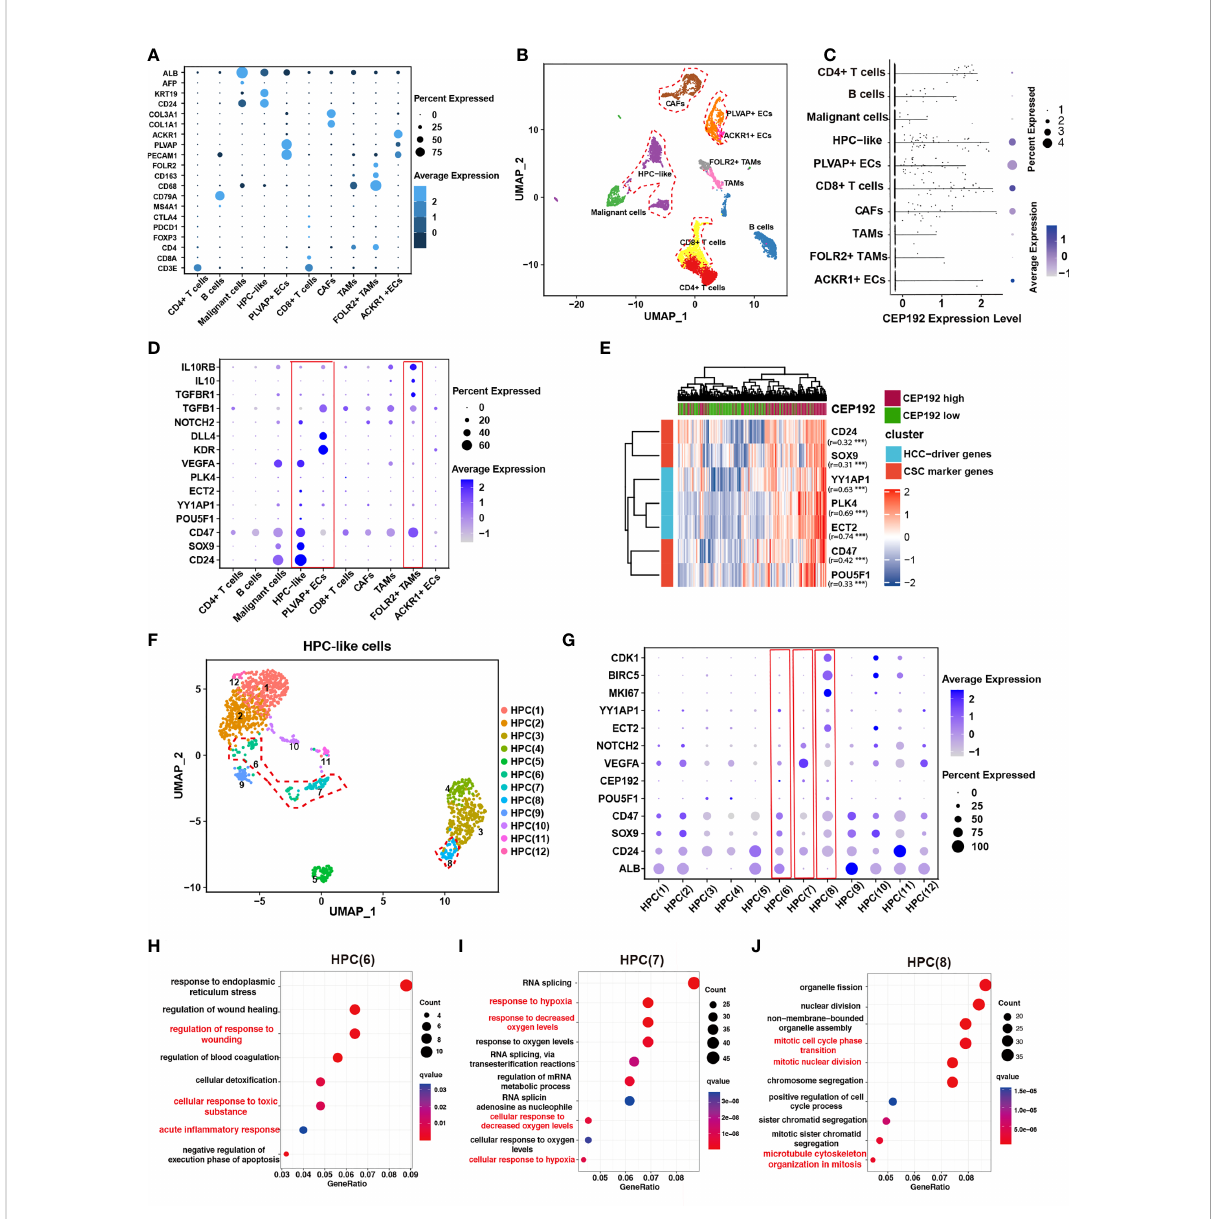
FIGURE 4 CEP192 was associated with hepatic progenitor cell-driven immunosuppressive ecosystem in liver cancer. (A) Dot plot depicting the typically cell-type-speci fi c markers in liver cancer (GSE125449). (B) UMAP plot of cell types from 19 tumors (indicated by colors). Cells were annotated as CD4+ T cells, CD8+ T cells, B cells, malignant cells, hepatic progenitor-like cells (HPC-like), endothelial cells that expressed PLVAP genes (PLVAP+ ECs, tumor-speci fi c ECs with fetal-like property), endothelial cells that expressed ACKR1 genes (ACKR1+ ECs), cancer-associated fi broblasts (CAFs), tumor-associated macrophages (TAMs), and TAMs that expressed FOLR2 (FOLR2+ TAMs, fetal-like TAMs with immunosuppressive property) according to cell-type-speci fi c marker genes in (A) . (C) The expression distribution of CEP192 in liver cancer. (D) Expression of gene sets involved in maintaining the immunosuppressive onco-fetal tumor microenvironment via the VEGFA/NOTCH signaling in liver cancer. Red boxes highlighted cell clusters that reprogrammed the immunosuppressive onco-fetal ecosystem. (E) Heatmap of positive correlation between CEP192 and liver cancer stem cell markers. (F) Sub-clustering of HPC-like cells identi fi ed 12 cell types. HPC clusters with high CEP192 expression were highlighted in red contours. (G) Dot plot of HPC cluster marker genes across HPC-like cells. Red boxes highlighted HPC clusters of high CEP192 expression. (H – J) Bubble plot showing the GO-BP enrichment results of HPC(6) (H) , HPC(7) (I) , and HPC(8) (J)